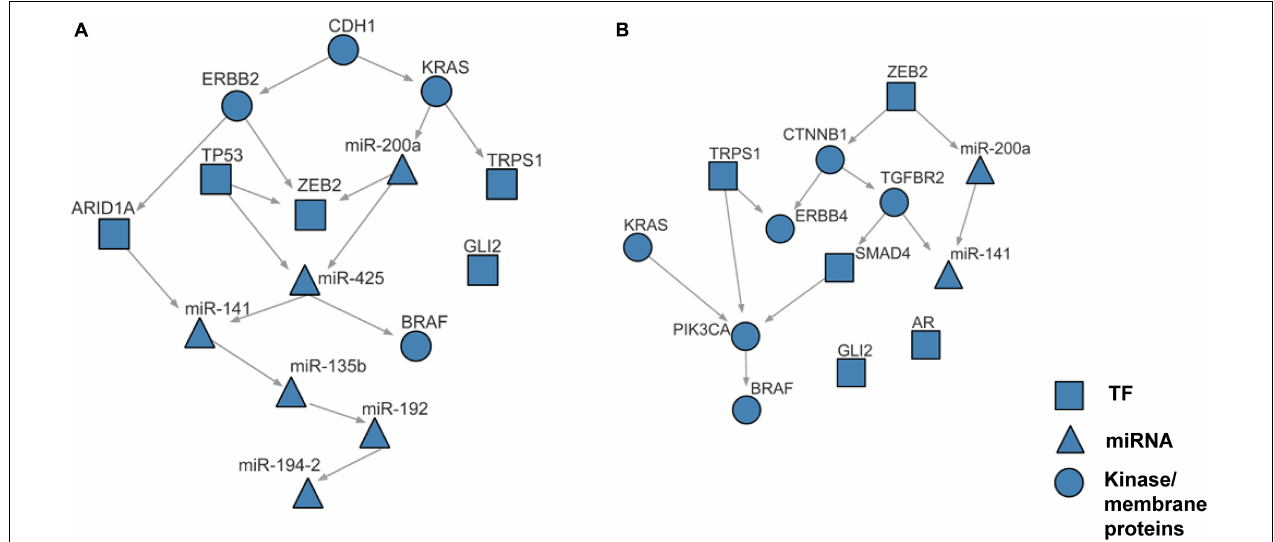
FIGURE 5 | The case studies of NEM-Tar on gastric cancer and colorectal cancer. (A) Reconstructed signaling network for the EMT subtype of gastric cancer. (B) Reconstructed signaling network for the CMS4 subtype of colorectal cancer.